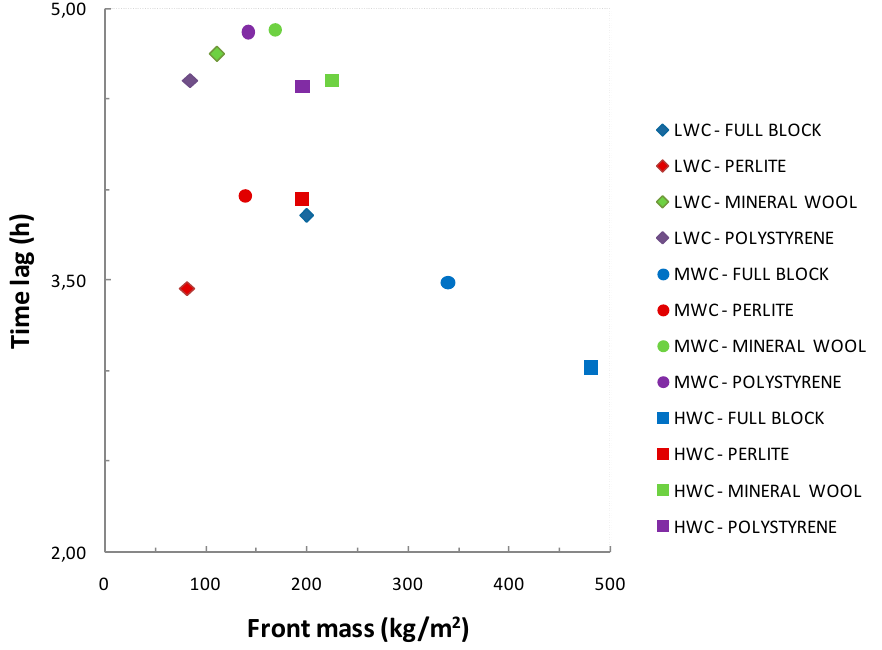
Figure 7. Time lag (in hours) vs. front mass, all material combinations.